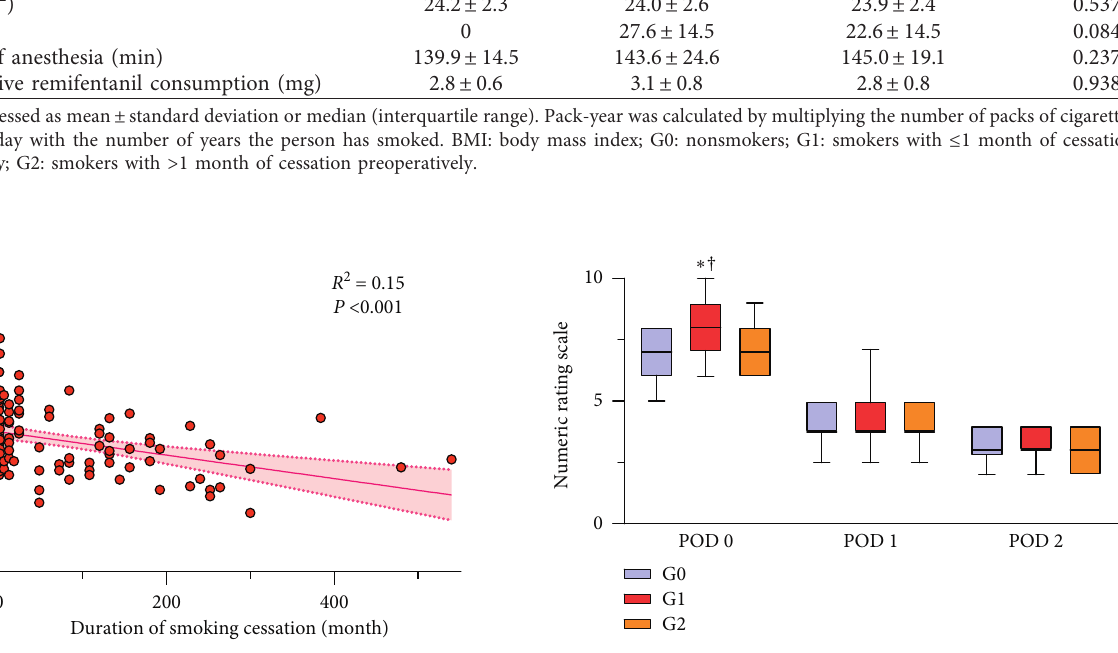
Figure 2: Scatterplot and regression line of opioid requirements according to the duration of smoking cessation. Pink zone between dotted lines indicates the 95% confidence interval.